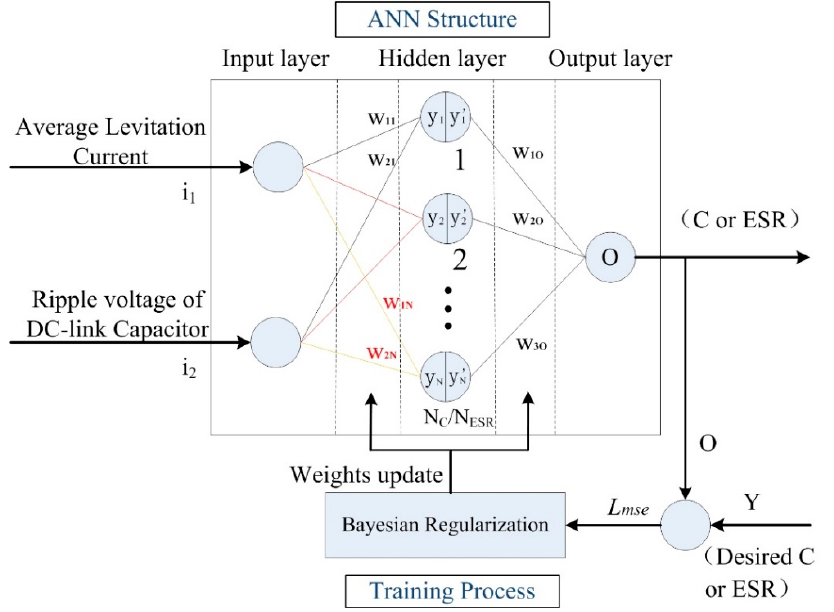
Figure 5. Structure of the ANN for C and ESR estimation.